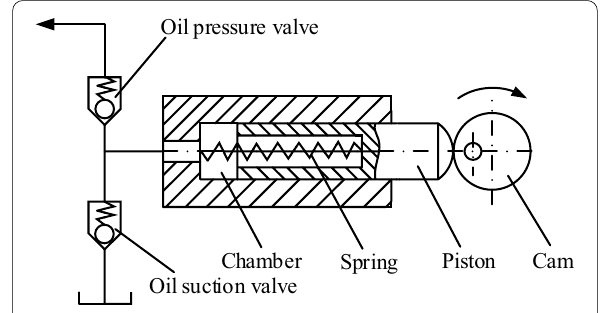
Figure 1 Working principle of positive displacement pump